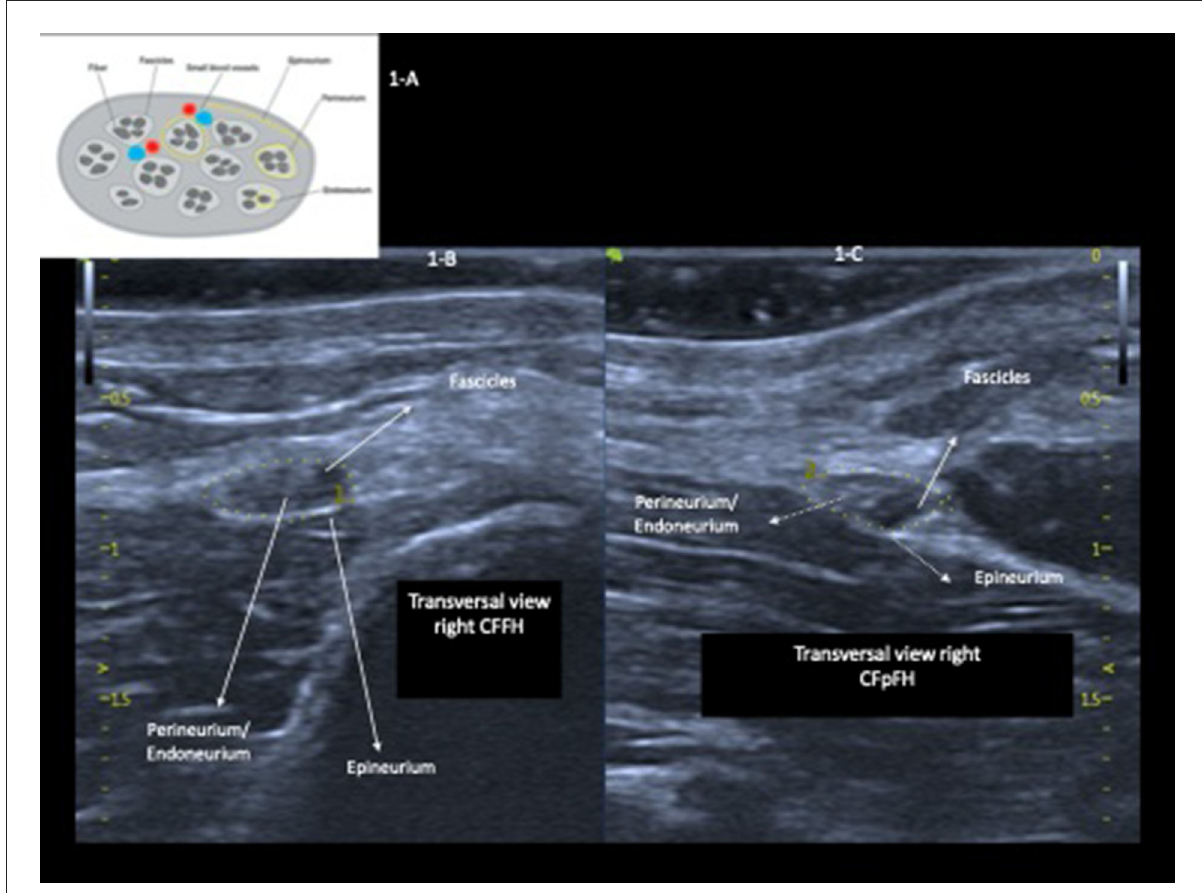
FIGURE1 Drawing of a cross-section of a peripheral nerve (A) ; high-resolution echography of the ulnar nerve in the right (RPT) and the left (LPT) cubital pretunnel with preserved cross-sectional area, echogenicity, and fascicular pattern (B,C)